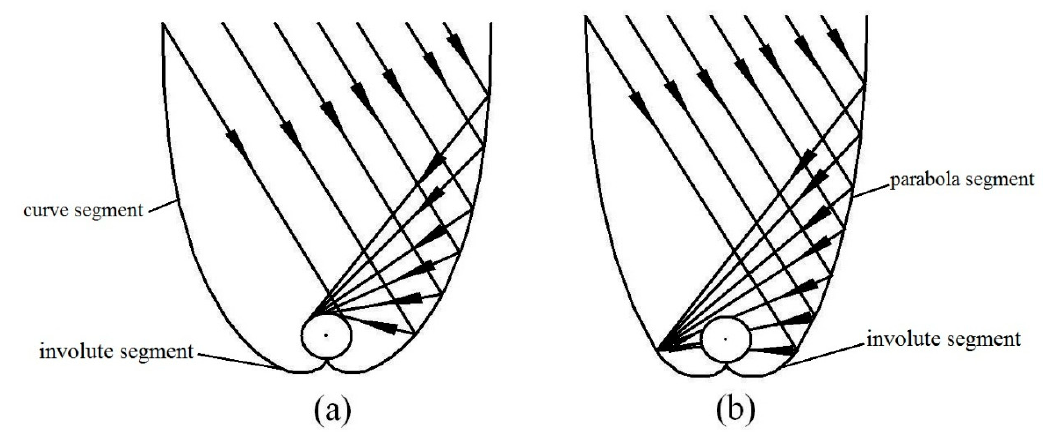
Figure 1. Two types of curves for tubular absorber compound parabolic concentrator (CPC): ( a ) Involute segment CPC profile; ( b ) curved segment profile.